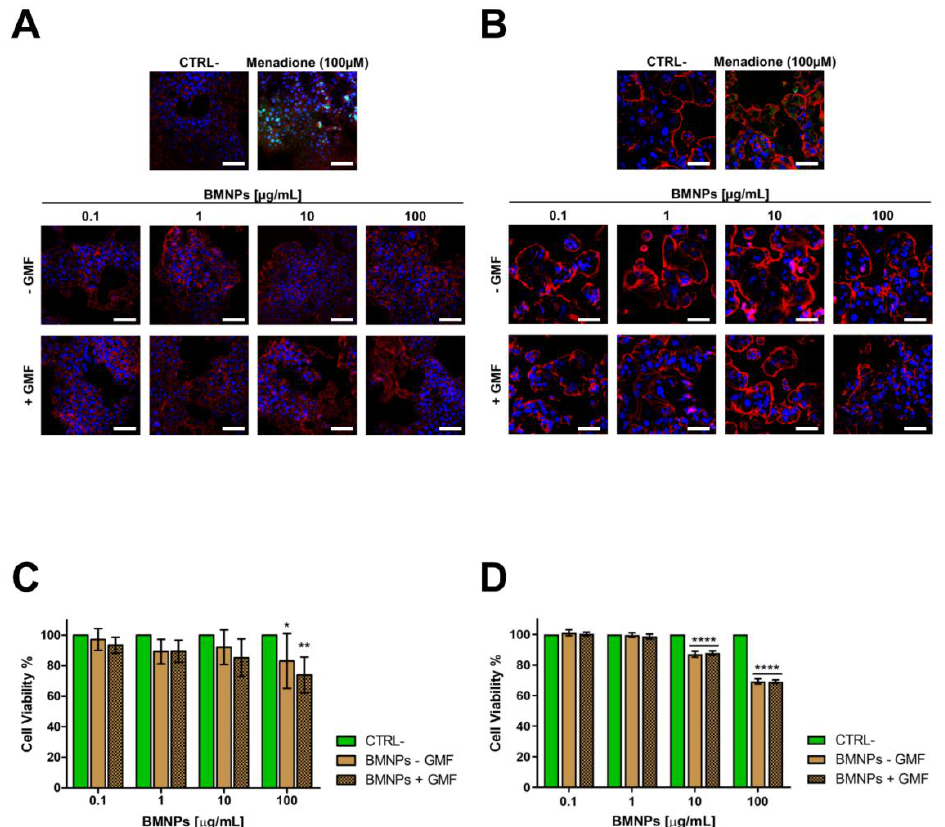
Figure 1. Cytocompatibility of biomimetic magnetic nanoparticles mediated by magnetosome proteins (BMNPs) on 4T1 ( A,C ) and MCF-7 ( B,D ) cells in the absence/presence of a gradient magnetic field: ( A,B ) Analysis of reactive oxygen species (ROS) production in the presence of different concentrations (0.1, 1, 10, and 100 µg/mL) of the BMNPs on 4T1 and on MCF-7 cells in the absence/presence of a gradient magnetic field by confocal microscopy. ROS production (green) was observed only in cells treated with menadione (100 µM), which was used as a positive control. Fixed and permeabilized cells were stained for actin with Tetramethylrhodamine B isothiocyanate (TRITC)-phalloidin (red) and for nuclei with TO-PRO3 (blue). Scale bar: 50µm. ( C, D ) Cell viability assessed in an Methylthiazolyldiphenyl-tetrazolium (MTT) assay after incubation with the same different concentrations of BMNPs for 72 h in presence/absence of a gradient magnetic field (GMF). Differences between groups were assessed by 2-way ANOVA with Dunnett’s multiple comparison test (**** p < 0.0001; ** p < 0.001; and * p < 0.05).